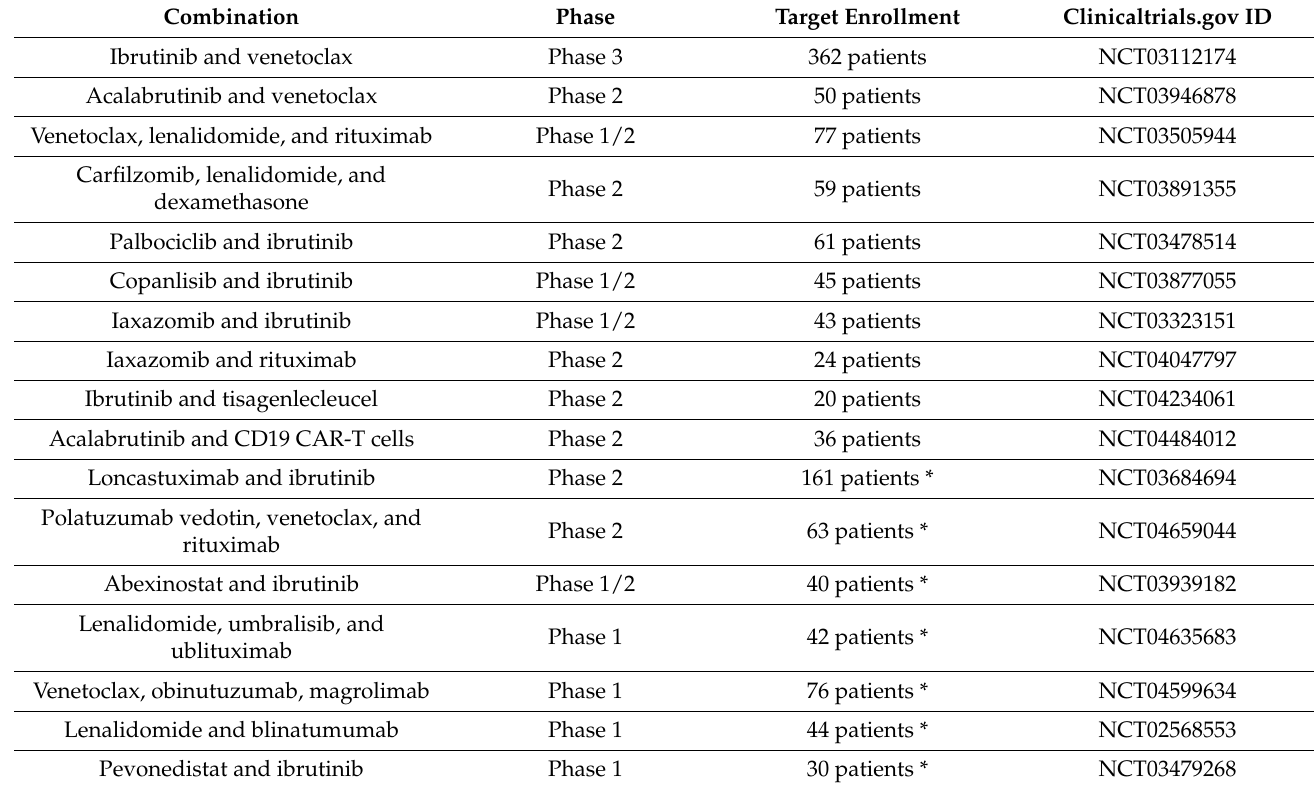
Table 2. Summary of Ongoing Combination Studies Enrolling Patients with Relapsed Mantle Cell